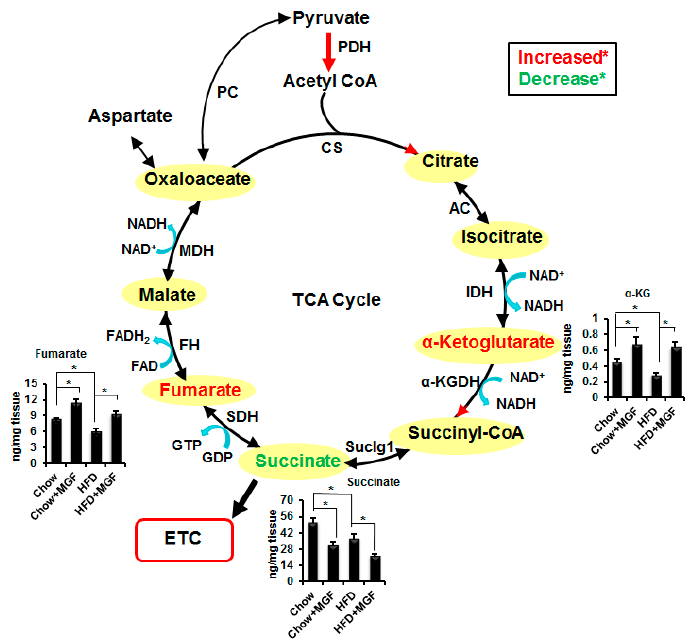
Figure 3. MGF modulates metabolite profiles in the TCA cycle. One-end arrows mean unidirectional and two-end arrows mean bidirectional. Significantly altered metabolites are presented in bar graphs. Values are average ± SEM ( n = 6). * p < 0.05. PC, pyruvate carboxylase; PDH, pyruvate dehydrogenase; CS, citrate synthase; AC, Aconitase; IDH, isocitrate dehydrogenase; α -KGDH, α -ketoglutarate dehydrogenase; Suclg, succinyl coenzyme A synthetase; SDH, succinate dehydrogenase; FH, fumarase; MDH, malate dehydrogenase; α -KG, α -ketoglutarate.